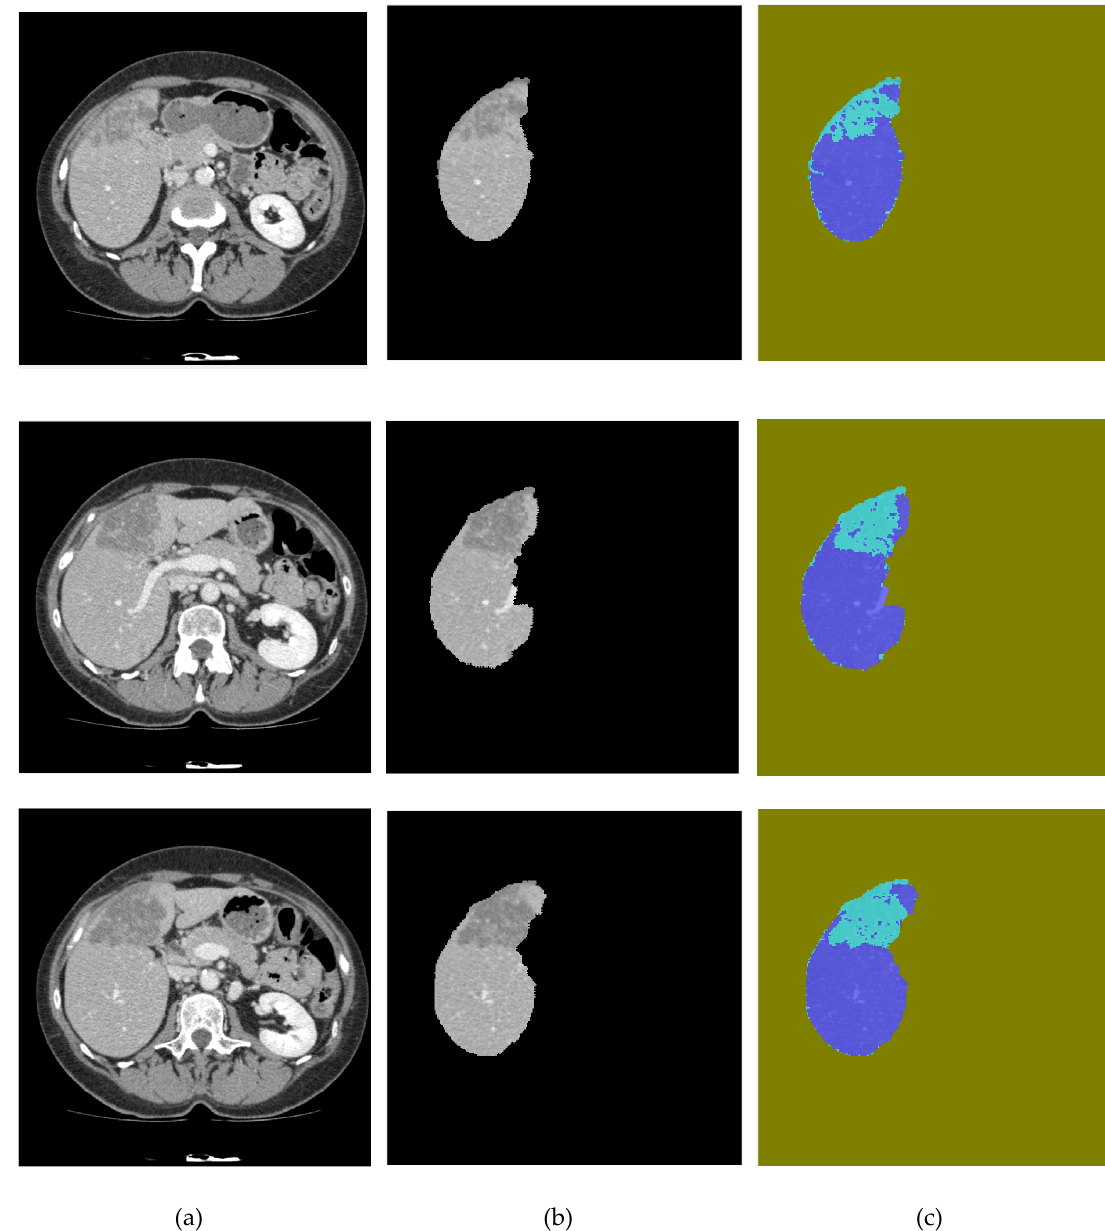
Figure 9. Segmentation results: ( a ) original image, ( b ) liver segmentation using SegNet, and ( c ) UNet predictions of liver lesions.